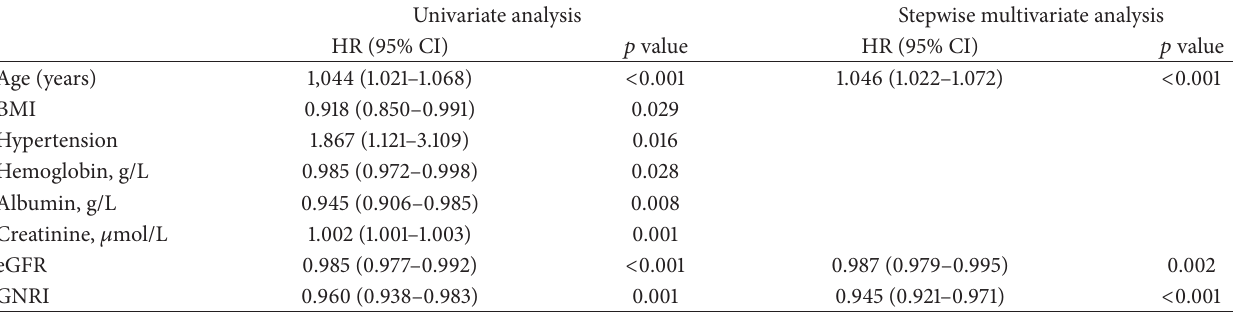
Table 2: Independent predictor of all-cause mortality in DFU with amputations.